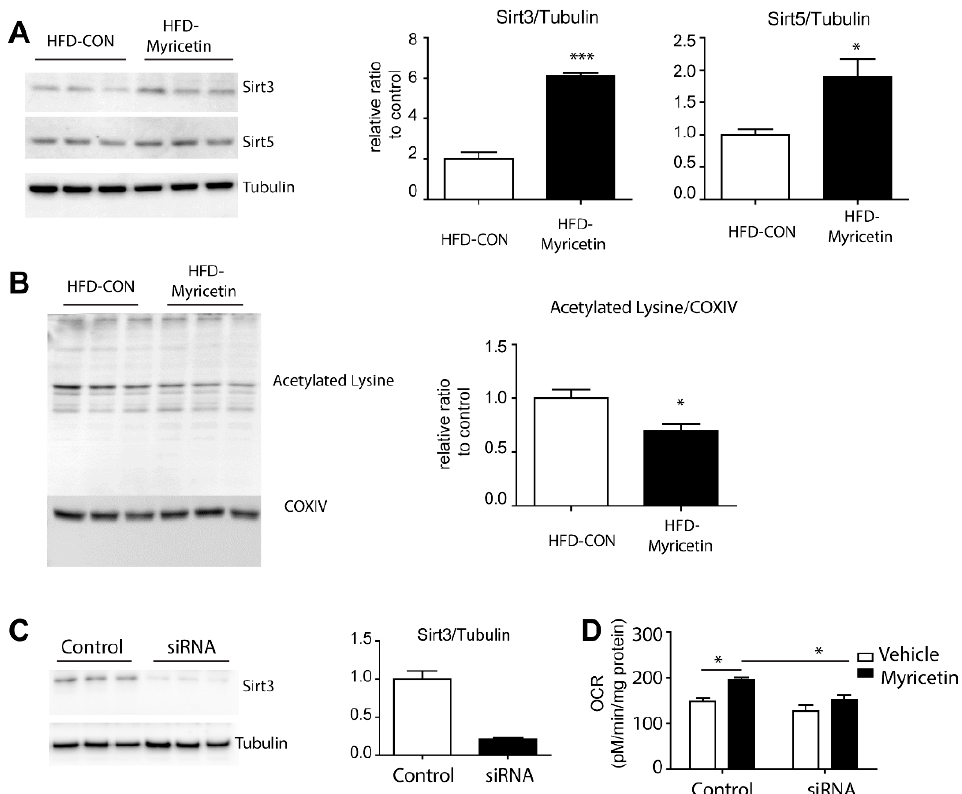
Figure 6. Effect of myricetin on Sirt3 expression and lysine acetylation level in inguinal adipose tissue of HFD-fed mice. ( A ) Immunoblot analysis of Sirt3, and Sirt5 in white inguinal adipose tissue of mice fed with HFD for 8 weeks. ( B ) Immunoblot analysis of acetylated lysine in mitochondrial fraction of white inguinal adipose tissue of mice fed with HFD for 8 weeks. ( C ) Immunoblot analysis of Sirt3 expression in adipocyte culture treated with siRNA targeting Sirt3. ( D ) Analysis of myricetin effect on OCR of fully differentiated adipocytesfrom C3H10T1/2 cells treated with siRNA targeting Sirt3. Myricetin was treated at the concentration of 10 µ M for 24 h. ( n = 3, means ± SEM, * p < 0.05, *** p <